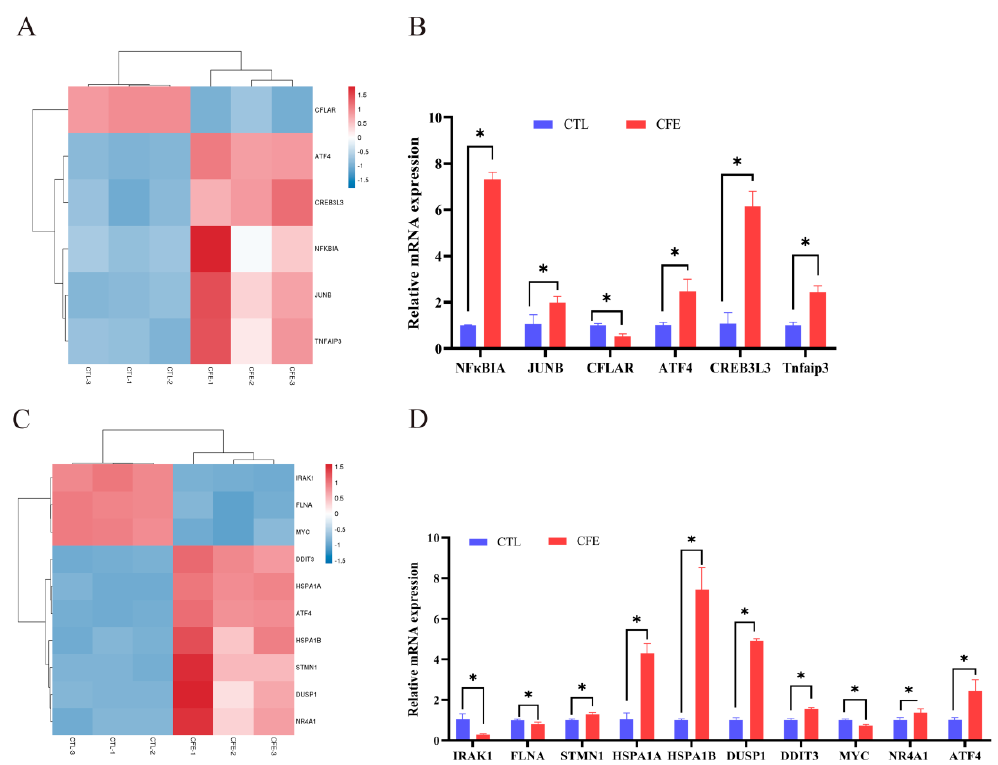
Figure 5. Effects of the cell − free extracts (CFEs) collected from L. plantarum YE4 (YE4 − CFE) on the genes related to the TNF and MAPK signaling pathway. ( A ) Heat map of the TNF signaling pathway. ( B ) Effect of YE4 − CFE on the expression of the TNF pathway − related genes in Caco − 2 cells. ( C ) Heat map of the MAPK signaling pathway. ( D ) Effect of YE4 − CFE on the expression of the MAPK pathway − related genes in Caco − 2 cells. CFE, treatment group after YE4 − CFE interacted with Caco − 2 cells; CTL, control group. Asterisks denote significant difference (* p < 0.05) between the CTL group and CFE group.